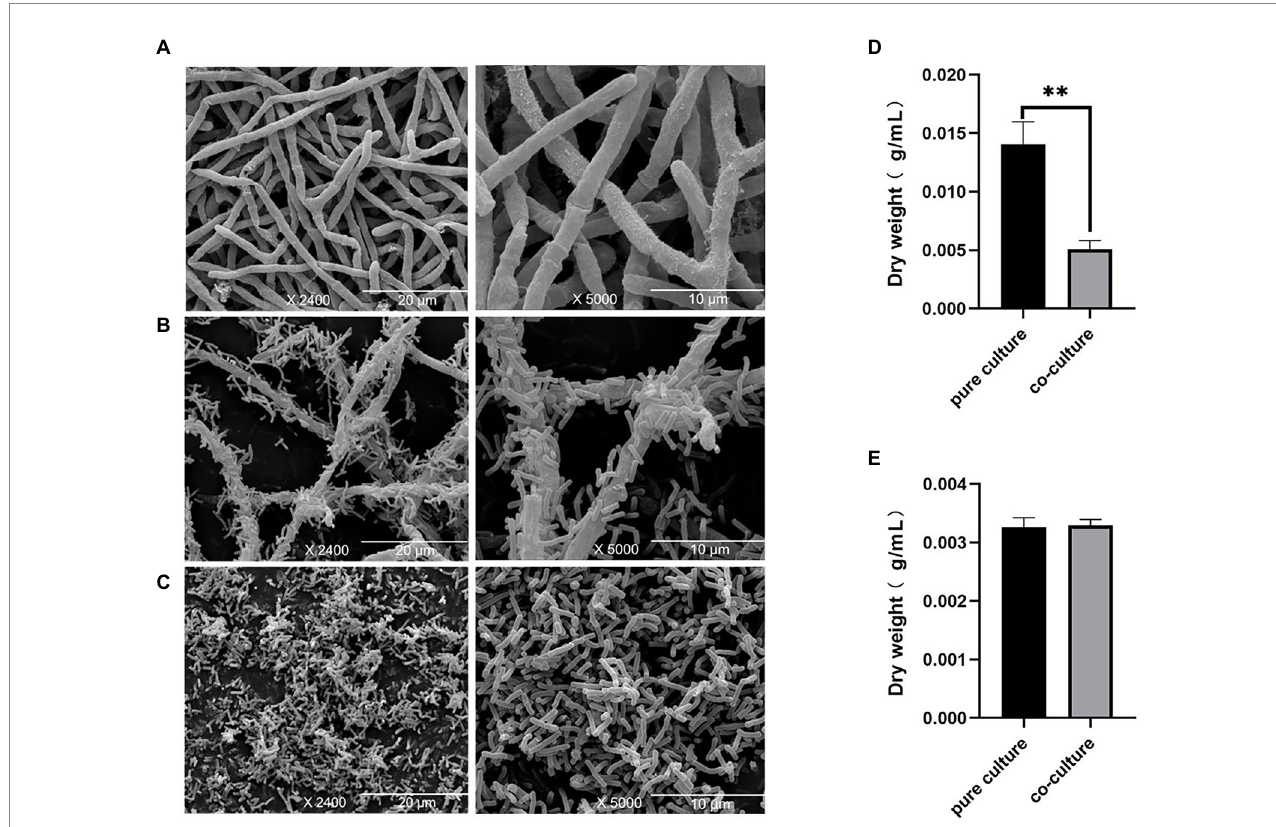
FIGURE 1 Scanning electron microscopy of Eurotium amstelodami mycelia in pure culture (A) , co-cultures (B) and Bacillus licheniformis pure culture (C) . Dried mycelial and cells weight of E. amstelodami (D) and B. licheniformis (E) . Data are reported as the mean value ± standard deviation of three replicates, Statistical significance (Student’s t-test) is indicated as follows: * p <